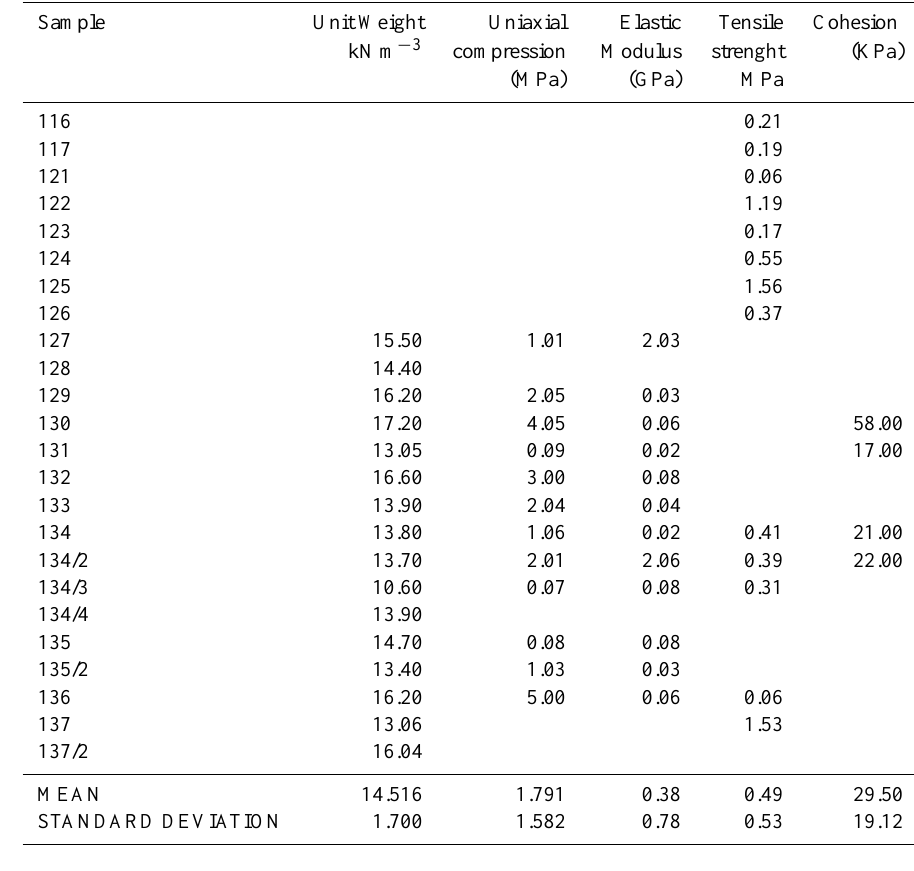
Table 5. Physical and mechanical characteristics of travertine from the area of collapse.